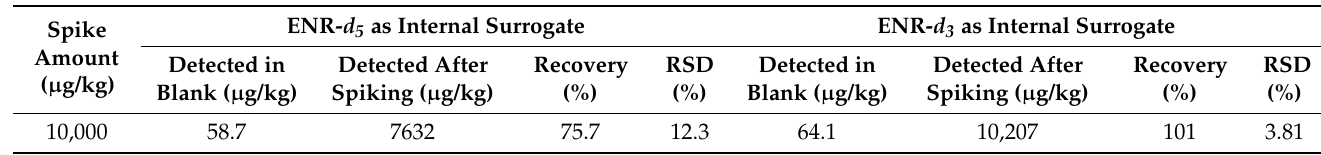
Table 2. Recovery and RSDs of a spiking experiment in a positive sample with the dual isotope surrogates method for the determination of ENR (n = 3).